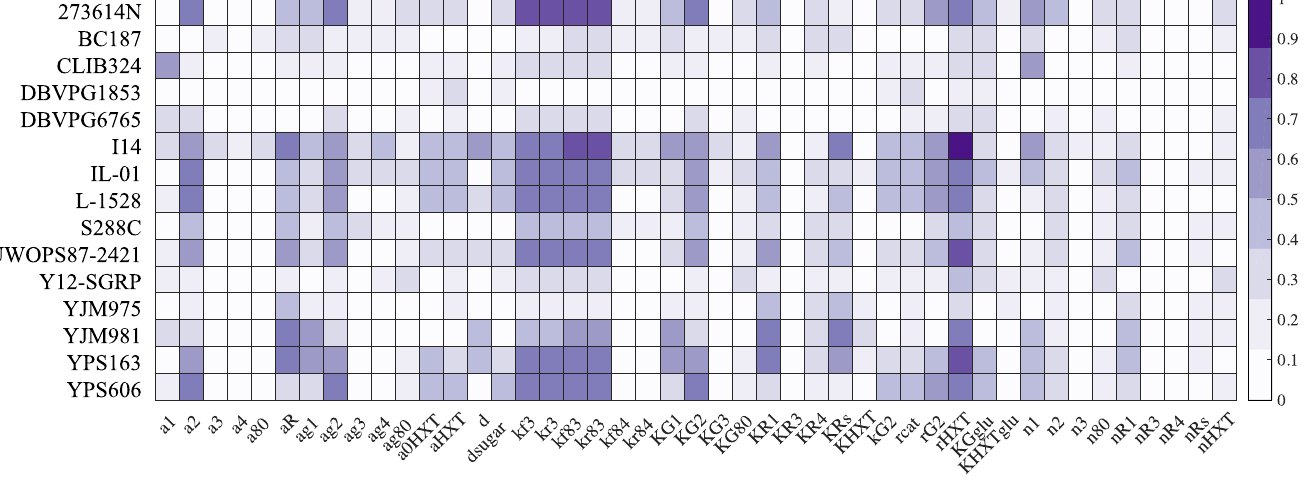
Fig 4. Fitting improvement matrix. A color-coded matrix showing to what degree each parameter modification could improve the fitting of each natural yeast isolate. Each row represents one of fifteen experimentally measured yeast strains, each column represents one of forty-five parameters in our model. The deeper the color means the more the fitting was